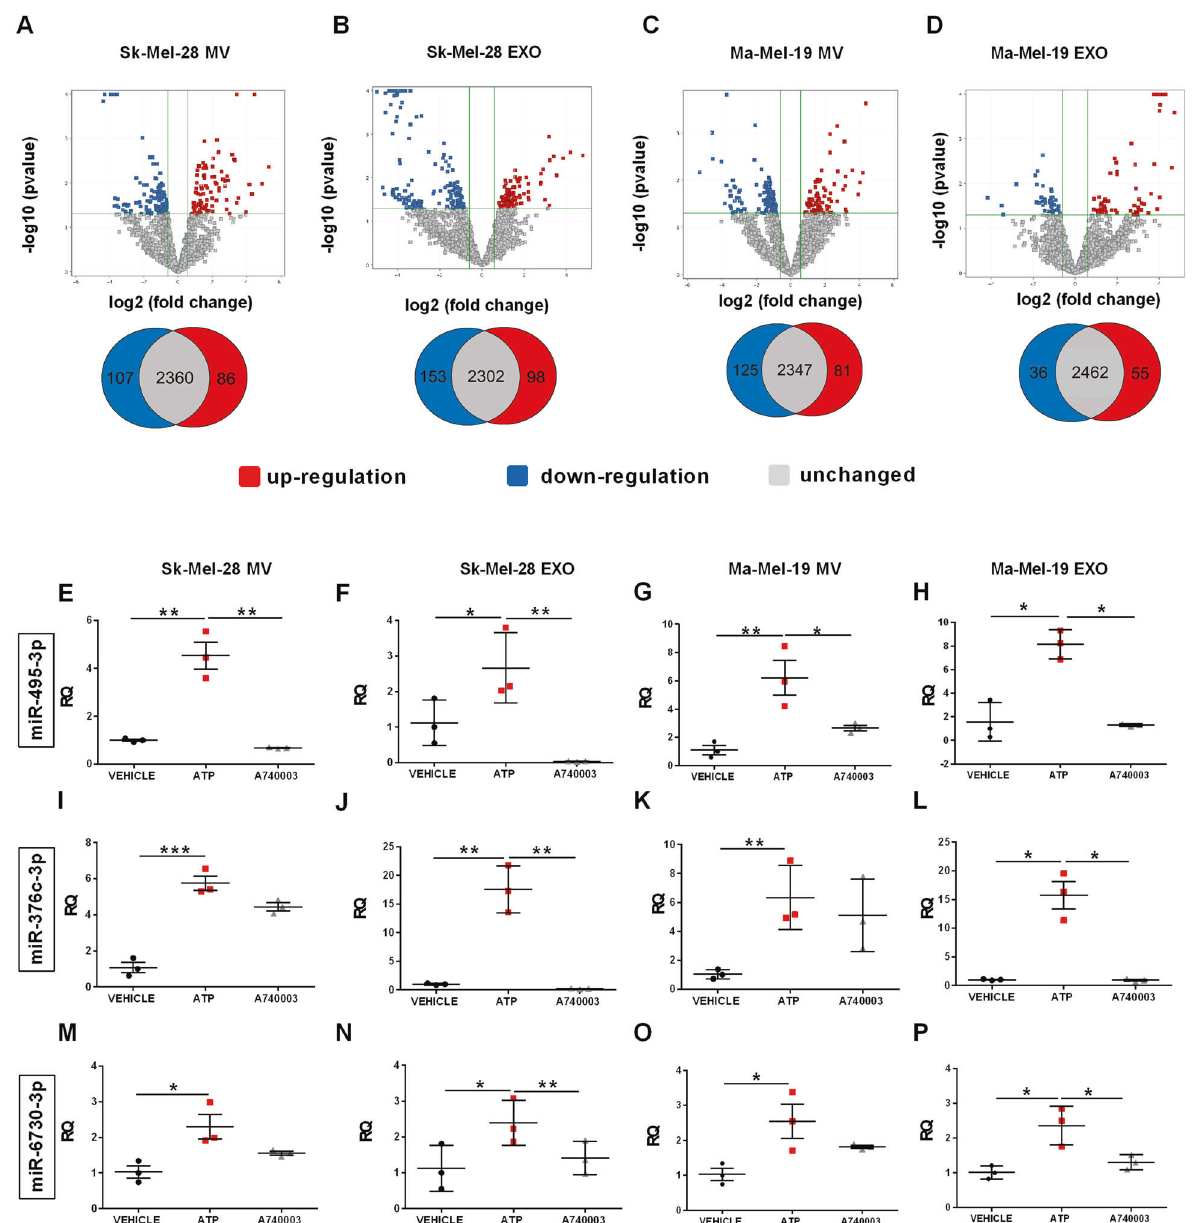
Fig. 7 ATP stimulation alters miRNAs content of EV released from melanoma cells. A – D Volcano plot, and Venn diagram of differentially expressed miRNAs in MV and EXO vesicle fractions released from Sk-Mel-28 ( A , B ) and Ma-Mel-19 ( C , D ) cells following stimulation with 3 mM ATP ( N = 3, three independent experiments). E – P Validation of selected miRNA expression levels by RT-PCR in MV and EXO from Sk-Mel-28 and Ma-Mel-19 cells following stimulation with 3 mM ATP. When required, 20 μ M A740003 was administered together with ATP. Expression levels of hsa-miR-495-3p in E Sk-Mel-28 MV, F Sk-Mel-28 EXO, G Ma-Mel-19 MV, H Ma-Mel-19 EXO. Expression levels of hsa-miR-376c-3p in I Sk-Mel-28 MV, J Sk-Mel-28 EXO, K Ma-Mel-19 MV, L Ma-Mel-19 EXO. Expression levels of hsa-miR-6730-3p in M Sk-Mel-28 MV, N Sk-Mel-28 EXO, O Ma-Mel- 19 MV, P Ma-Mel-19 EXO. Expression levels of the miRNAs are normalized on RNU6-1. N = 3, three independent experiments. * p < 0.05, ** p < 0.01, *** p < 0.001 by Student ’ s t